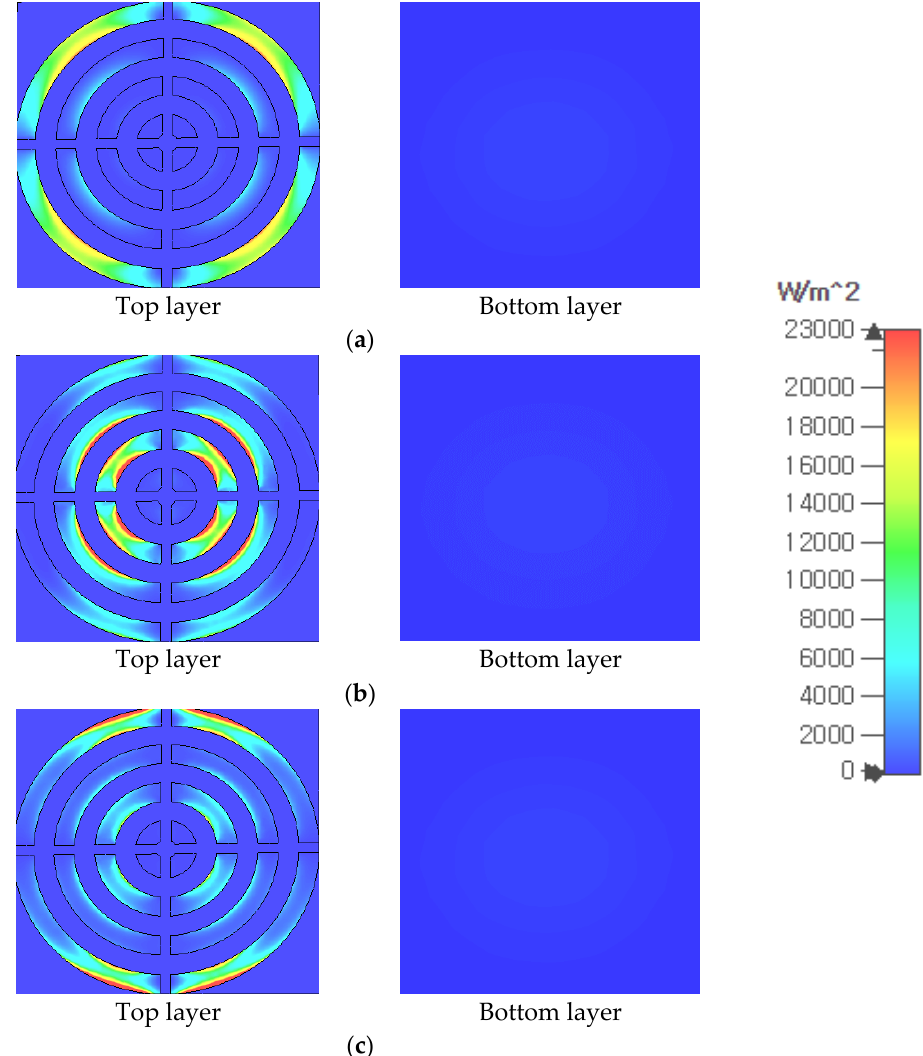
Figure 4. Surface power loss at the top and bottom layers at ( a ) 8.35 GHz, ( b ) 18.65 GHz, and ( c ) 21.65 GHz.